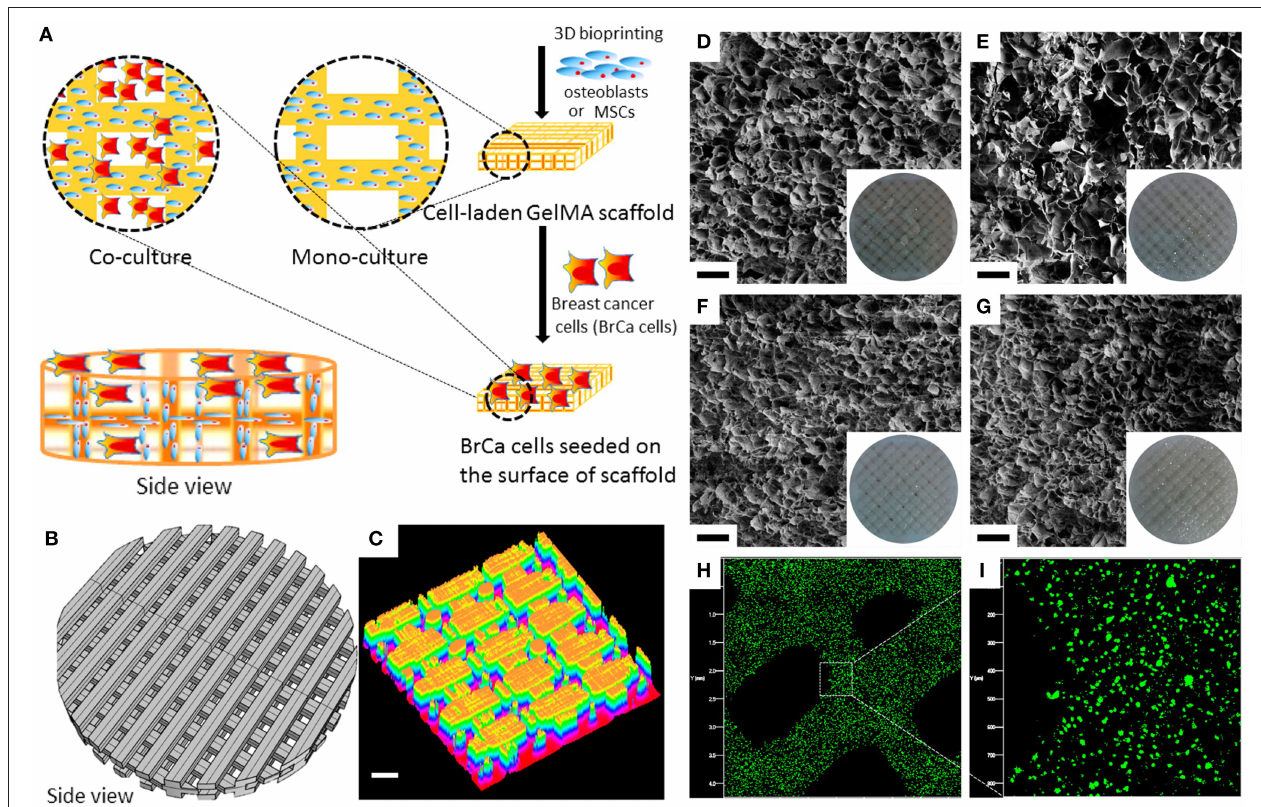
FIGURE 5 | An example of 3DBP breast cancer microenvironments. (A) Schematic diagram of direct, 3D bioprinted, cell-laden bone matrix as a biomimetic model for a breast cancer metastasis study. (B) CAD model of the 3D matrix. (C) 3D surface plot of the bioprinted matrix. Scale bar: 200 µ m. (D–G) Scanning electron micrographs (cross-sectional view) of porous matrices: (D) 10% GelMA, (E) 10% GelMA + nHA, (F) 15% GelMA, and (G) 15% GelMA + nHA, respectively. Scale bar: 100 µ m. The inset images are photographs of the corresponding matrices. (H,I) Fluorescence micrographs of the 3D bioprinted MSC-laden 10% GelMA matrix; 3D bioprinted cells were prelabeled by Cell Tracker Green CMFDA dye. GelMA; gelatin methacrylate ( A–I reproduced with permission from Zhou et al.,